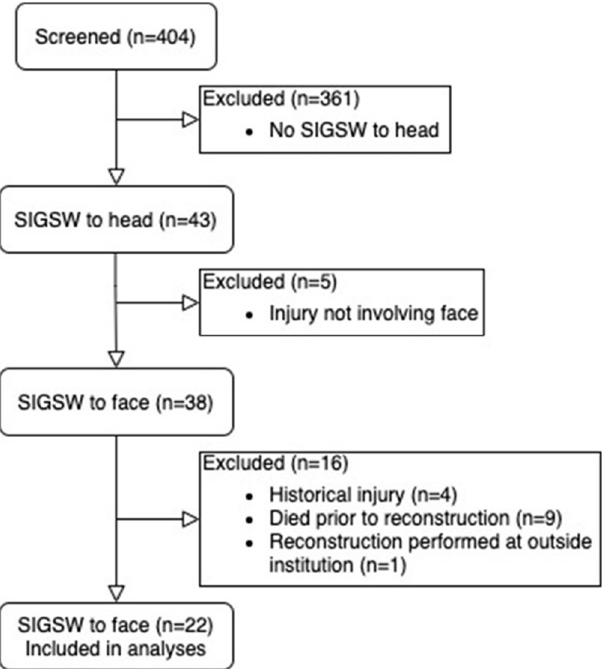
Figure 1. Cohort inclusion and exclusion criteria flow diagram.